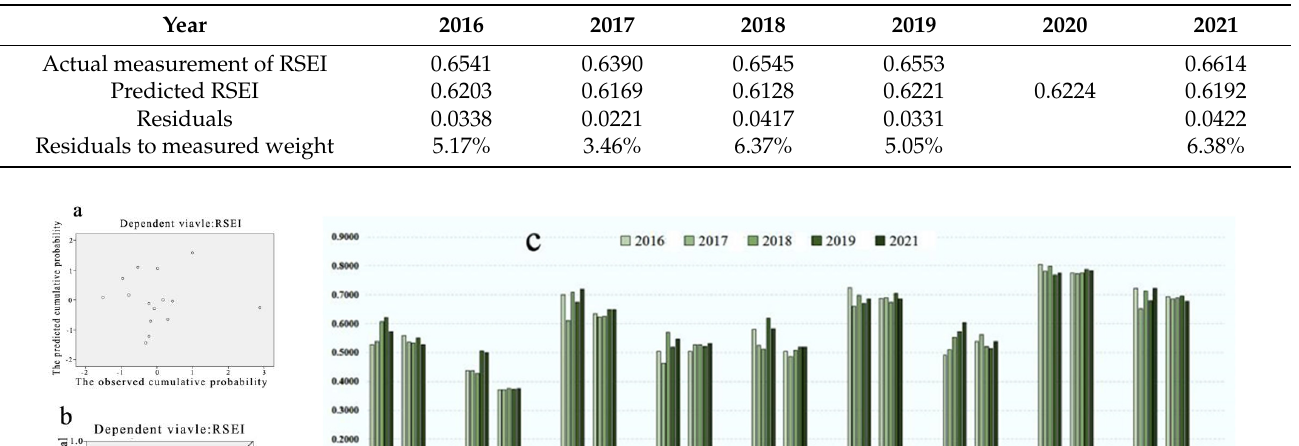
Table 2. Analysis of PAR contribution to RSEI during the implementation period.